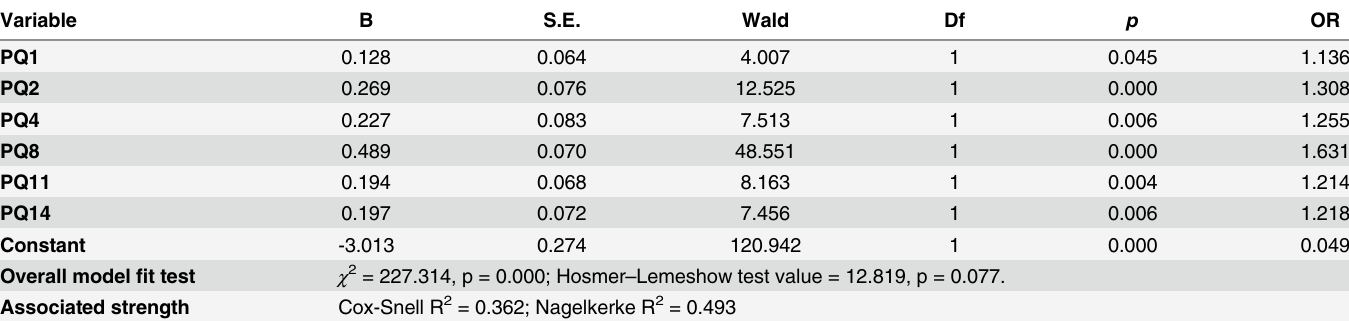
Table 4. Logistic regression of dichotomized SIPS diagnoses by PQ-B items. Variable